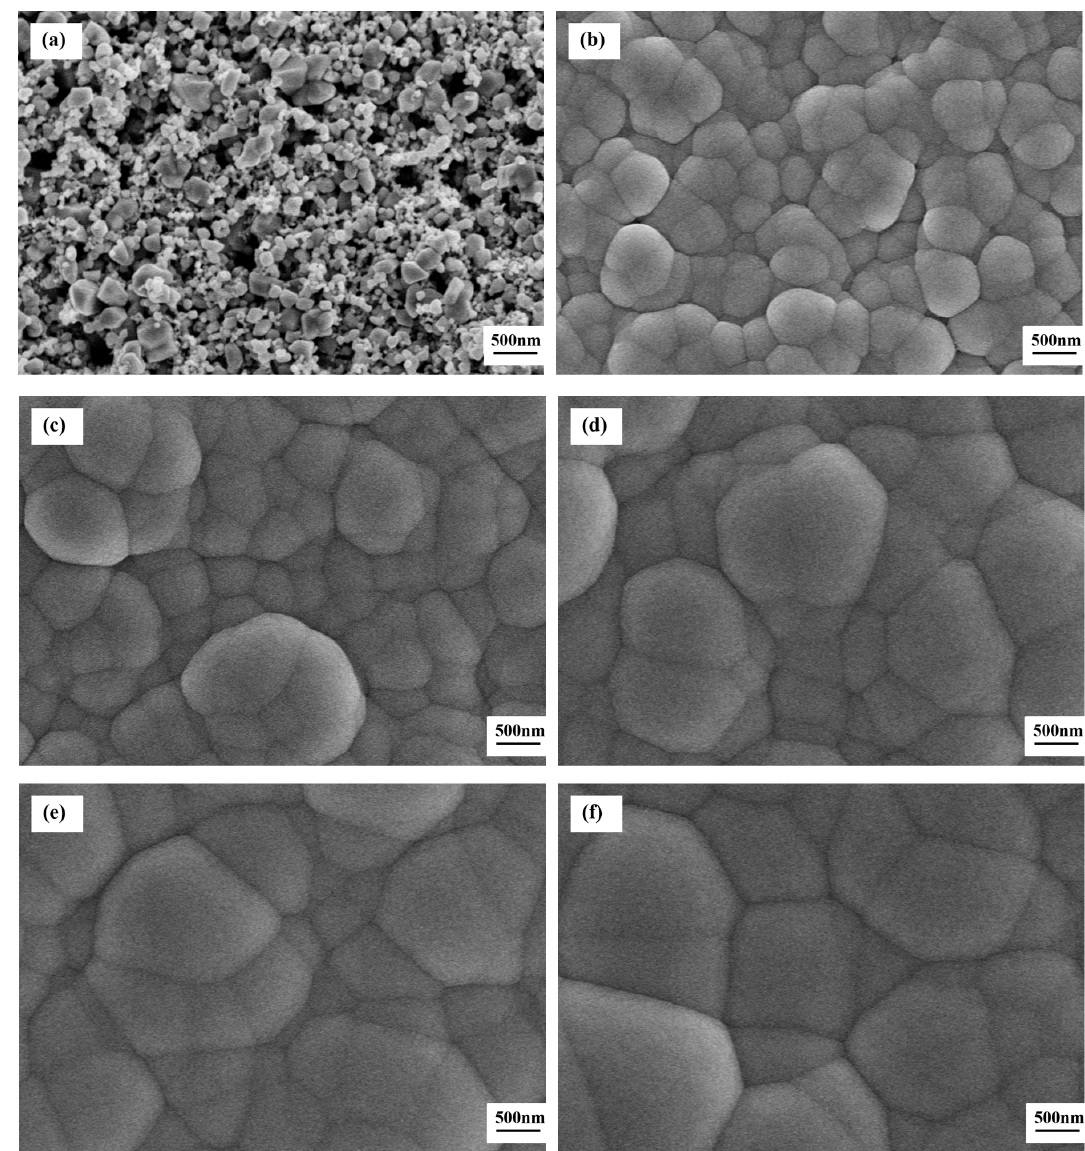
Figure 7. SEM micrographs of surface morphology of the sensors: ( a ) untreated and CVD-treated at 600 ° C for ( b ) 2 h, ( c ) 4 h, ( d ) 6 h, ( e ) 8 h, and ( f ) 10 h.